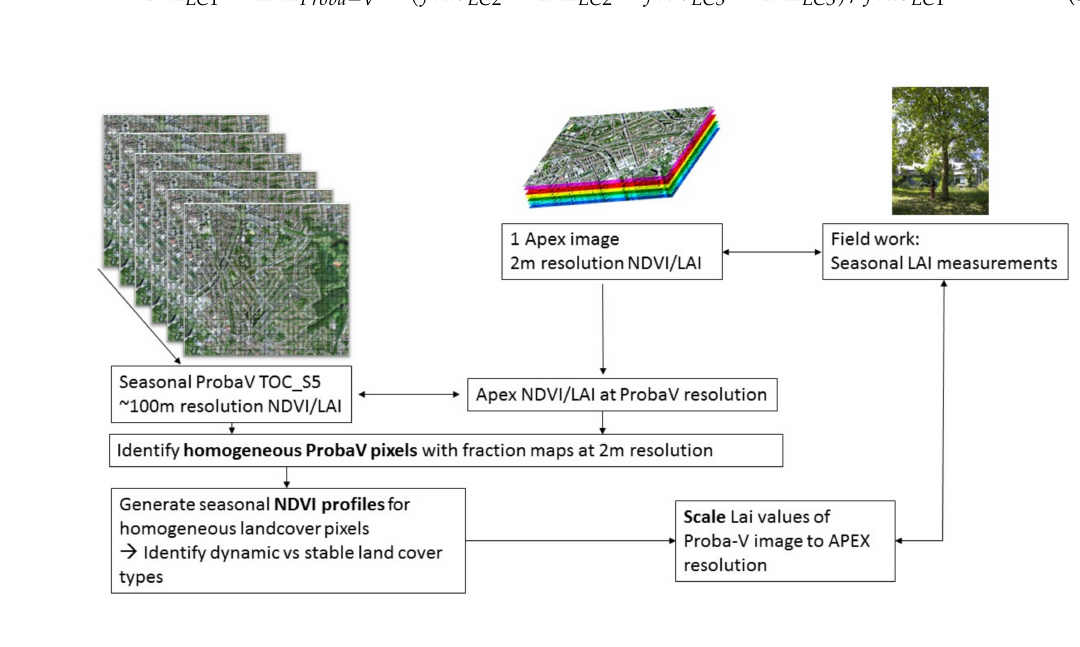
Figure 3. Monitoring urban vegetation dynamics based on RS products and ground-truth